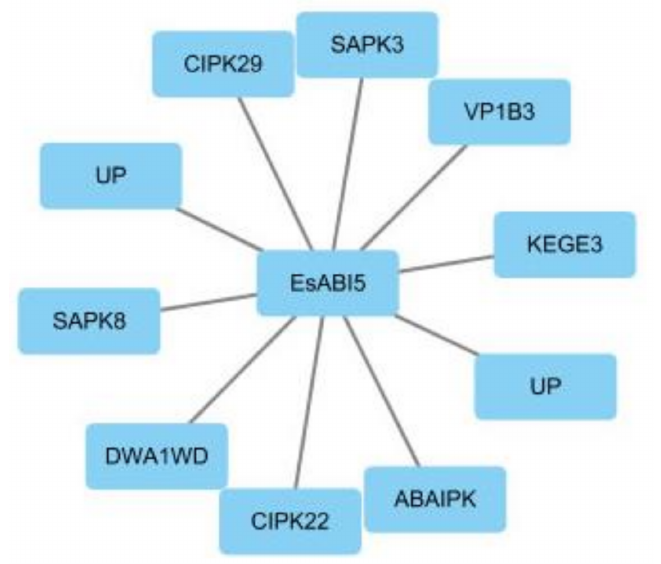
Figure 4. Analysis of proteins interacting with EsABI5